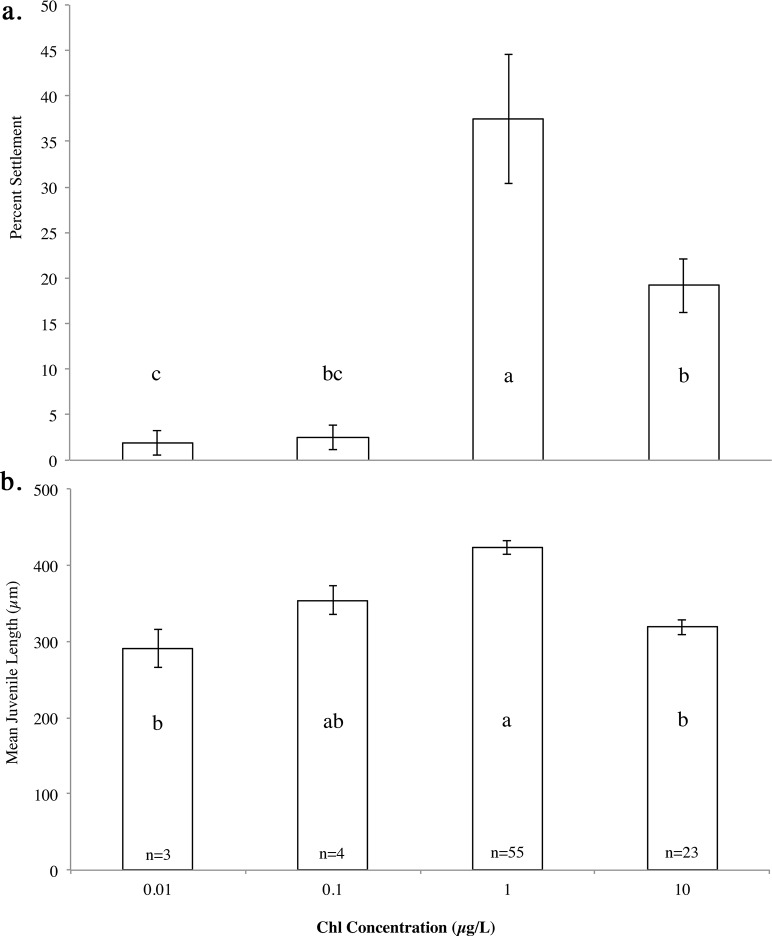
Average (a) percent settlement and (b) size of recently settled Acanthaster planci juveniles at day 18, following rearing larval rearing in five algal concentrations represented as chl a concentration (μg L-1) across all settlement assays (±se).Tukey’s HSD test: levels not connected by the same letter are significantly different.